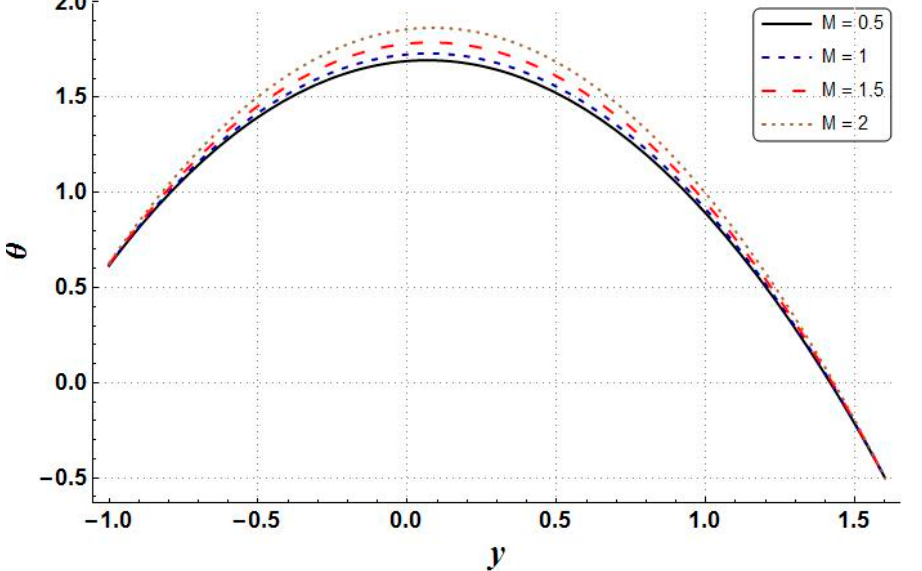
Figure 3. Influence on θ through changing values of M , where γ = π φ = 0.05, k = 2, a = 0.6, m = 1, d = 0.7, Br = 0.2, b = 0.5, ∈ = 2, η =